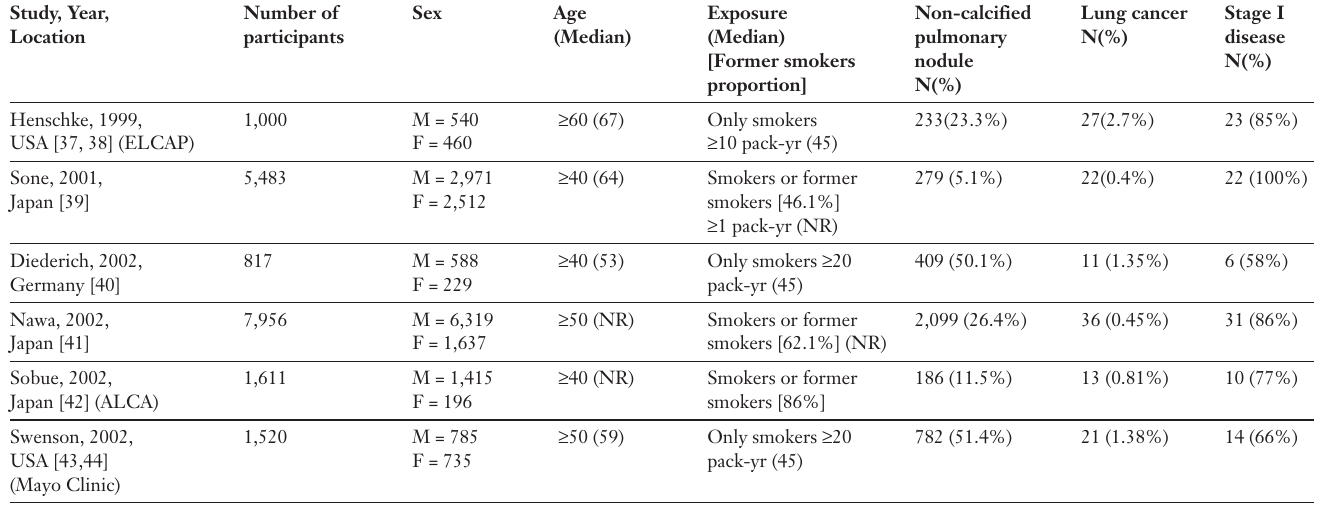
Observational studies evaluating LDCT as a screening tool [NR: not reported]. Study,